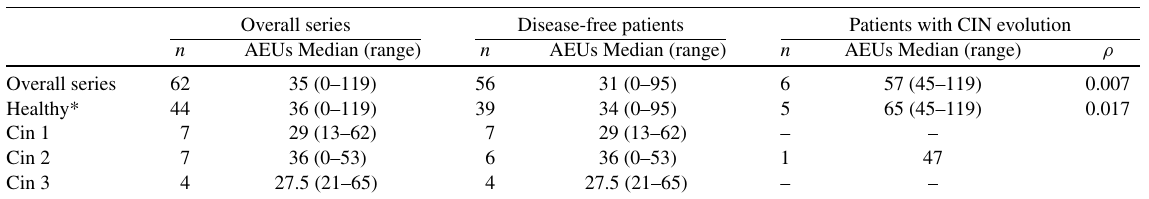
TRAP (AEUs) of uterine cervix and 5-year clinical outcome Overall series Disease-free patients Patients with CIN evolution n